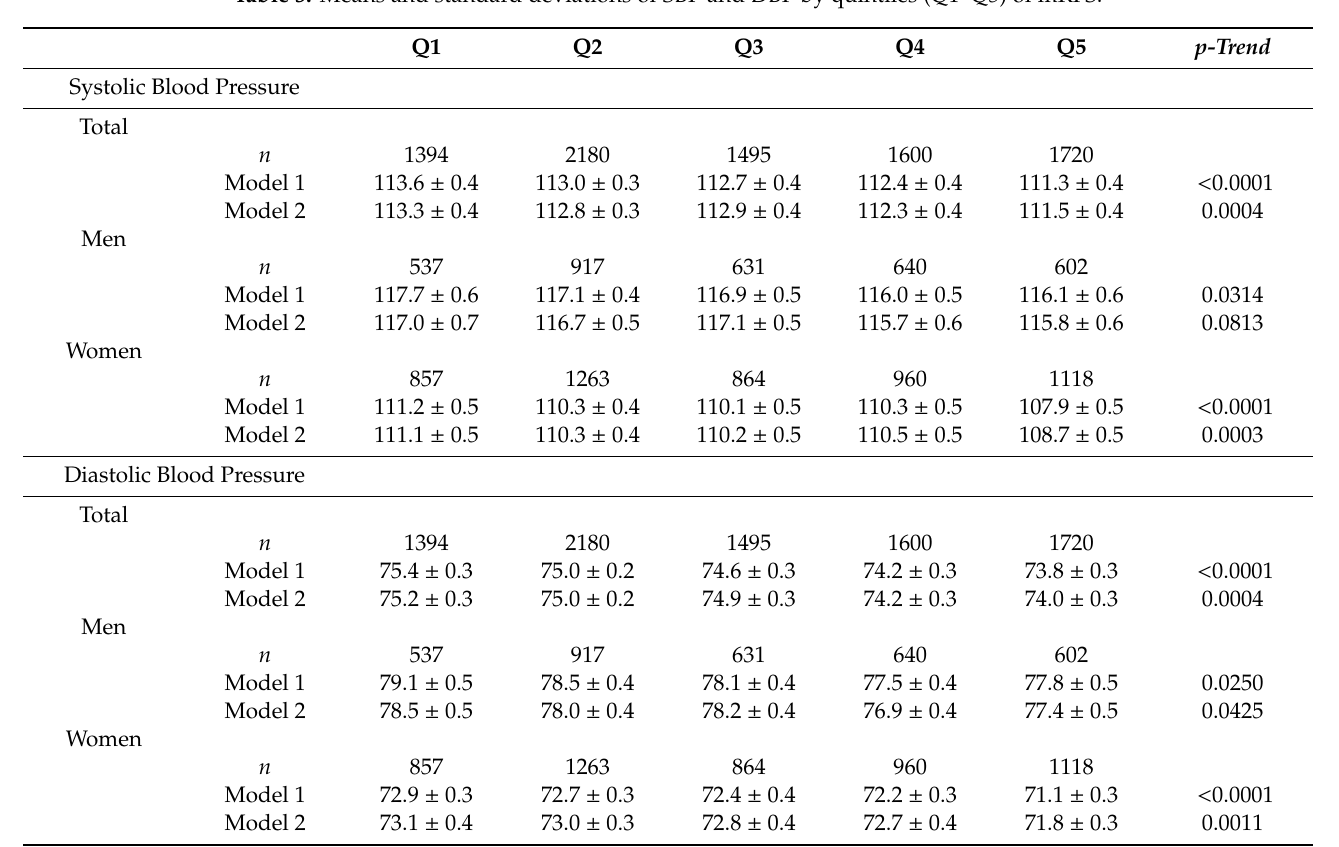
Table 3. Means and standard deviations of SBP and DBP by quintiles (Q1–Q5) of